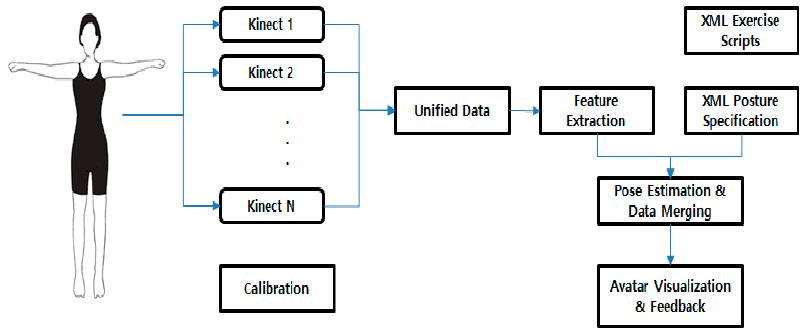
Figure 4. The process of multi-Kinect pose estimation for the Chongchong Step Master exergame.